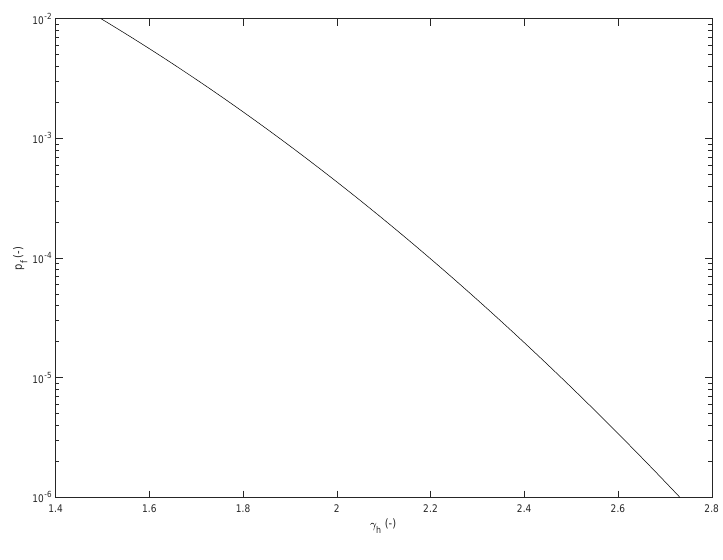
Figure 9. Partial safety coefficients γ h , as function of the failure probability p f